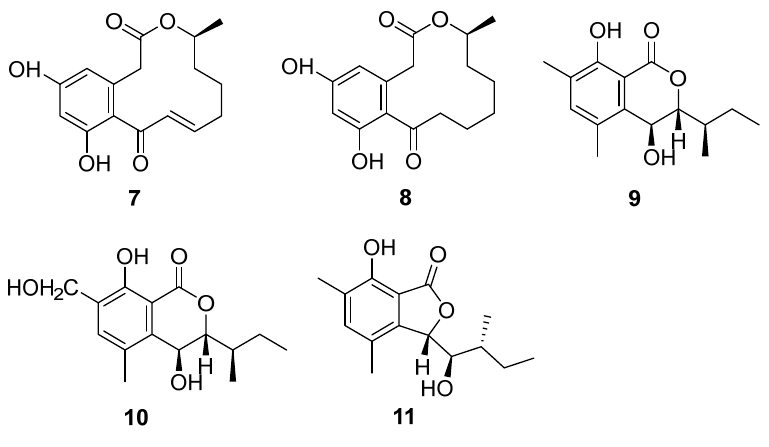
Figure 4. Structure of lactones 7 – 11 [17,29].